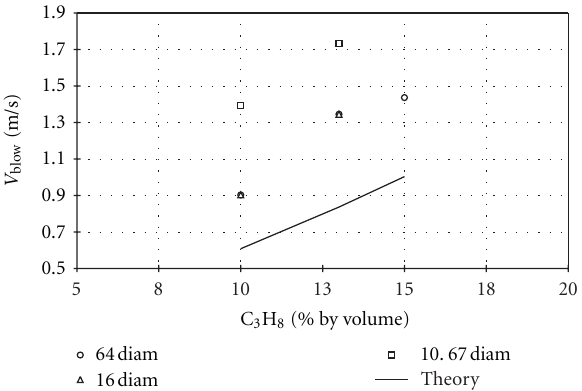
Figure 21: Blow-o ff velocity for nitrogen-diluted mixtures of C 3 H 8 .